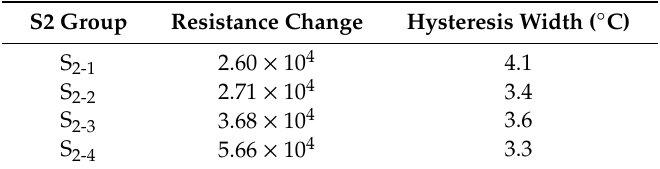
Table 1. The resistance change and the hysteresis width of the samples in the S 2 group.